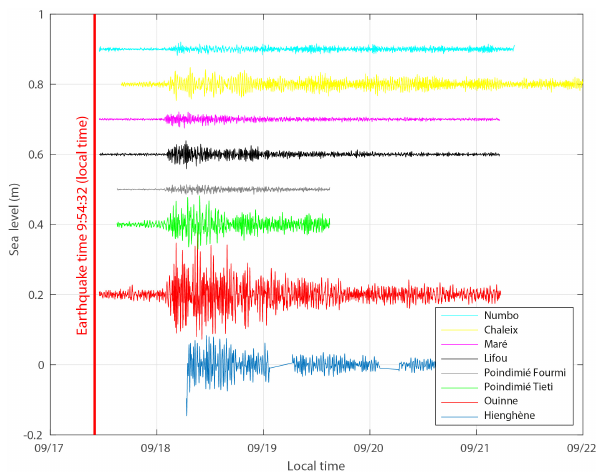
Figure 9. Sea-level variations recorded by tide and pressure gauges in New Caledonia following the 5 December 2018 Vanuatu earth-